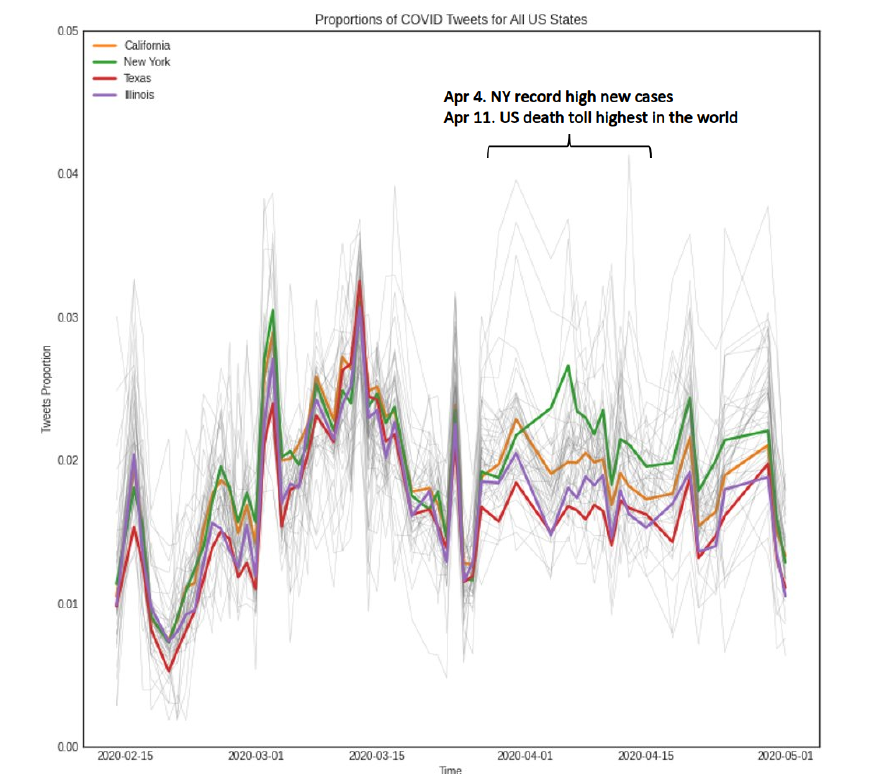
Figure K.2. State-level spatial distribution of Tweet proportions generated from all topics on the COVID (health care) path. California, New York, Texas, and Illinois are highlighted for illustration, while all other states are plotted in grey. Note that a time period in April is annotated with relevant events explaining the surge in tweet proportions in many states. This validates the quality of this shortest path using real-world